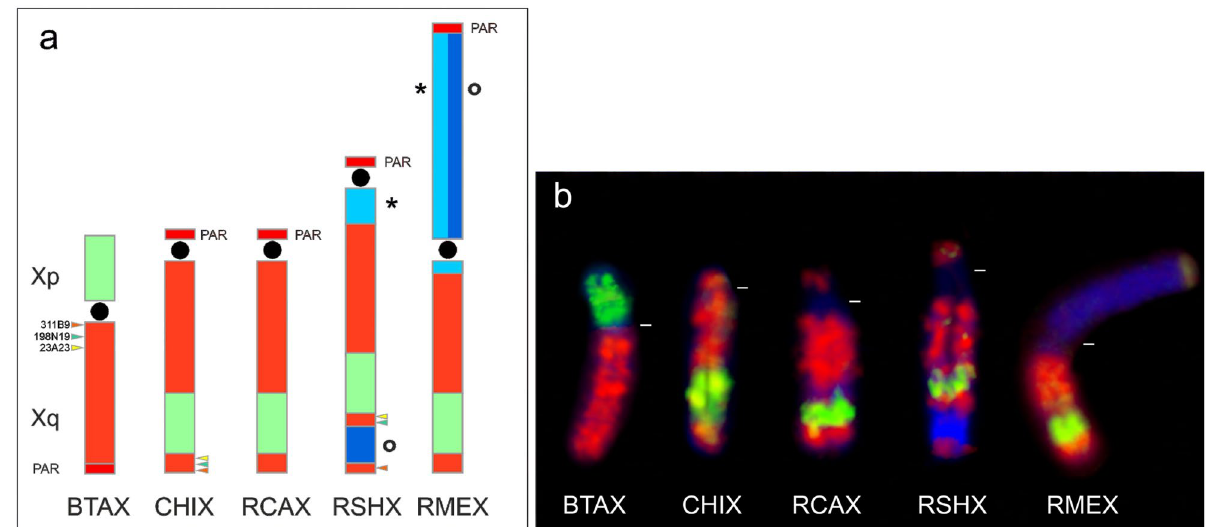
Figure 4. The morphology of the X chromosome differs among the Raphicerus species. All three show the presence of the so-called “acrocentric caprine X” (also referred to as the Suni type) with sequences orthologous to BTA Xp transposed approximately two thirds down the length of the euchromatic X chromosome 43 . ( a ) Schematic showing the relative positions of the BTA Xp (green) and BTA Xq (red) sequences and ( b ) FISH results using microdissected painting probes to this region. The distal heterochromatic block in RSH Xq was located between BACs 198N19 and 311B9. BAC 23A23 was proximal to 198N19. Key: * = satI DNA; O = SINE/ LINE DNA repeats; */O = RME Xp arm comprises both satI and SINE/LINE; PAR = pseudoautosomal